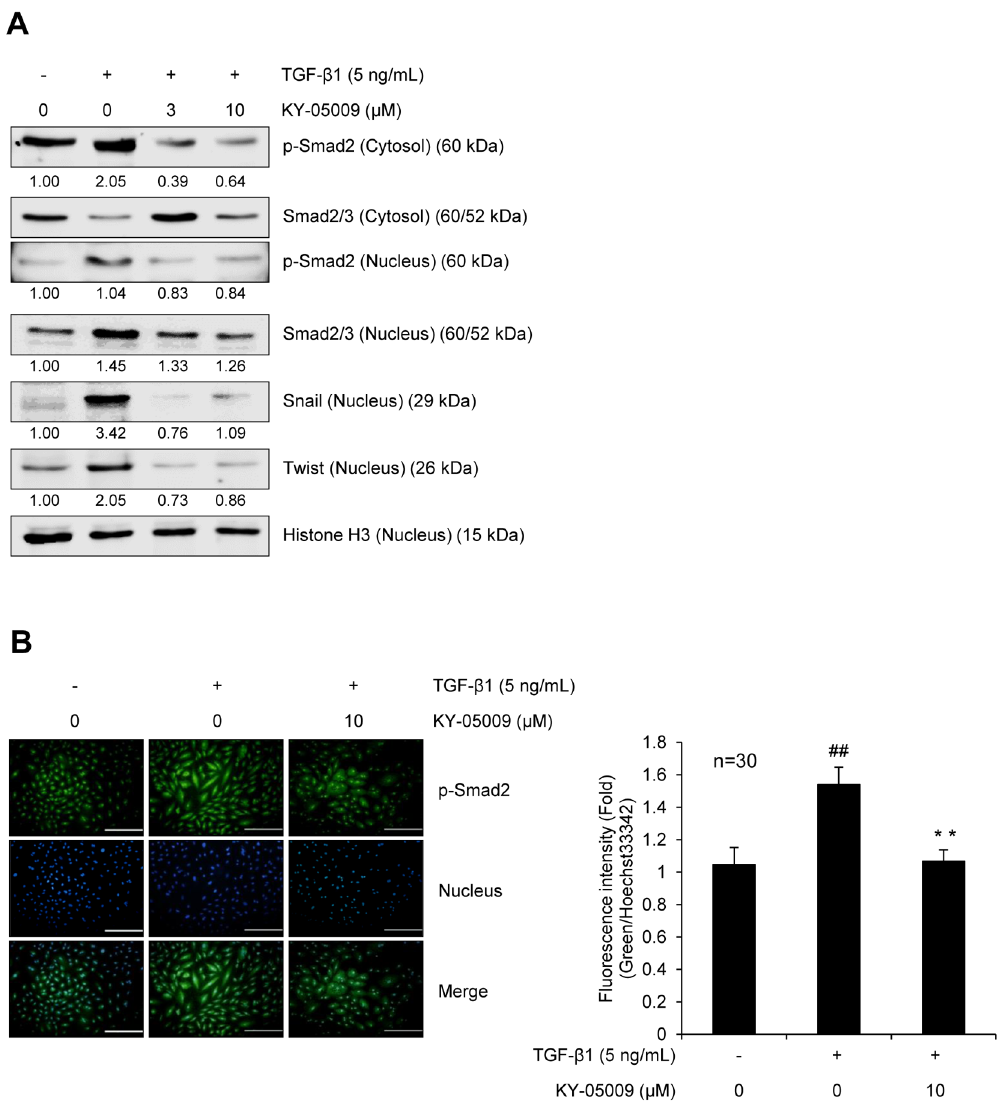
Figure 3. KY-05009 inhibits TGF- b 1-induced Smad signaling. (A) Effects of KY-05009 on TGF- b 1-activated Smad signaling. Serum-deprived A549 cells were treated with TGF- b 1 or its combination with KY-05009 for 48 h, and then the levels of p-Smad2 and endogenous Smad2/3 in cytosolic and nuclear fractions were evaluated by Western blot analysis. The nuclear expression levels of Snail and Twist were also evaluated. The expression of cytosol p-Smad2 was normalized by endogenous Smad2/3 and all nucleus proteins were normalized by histone H3. (B) Immunocytochemical confirmation of KY-05009 inhibition of TGF- b 1-activated p-Smad2. Nuclei were counterstained with Hoechst 33342. All scale bars represent 50 m m. The expression of p-Smad2 was represented by the relative intensity of green fluorescence (n=30), and reported images are representatives of triplicate experiments. ## p , 0.01 (versus ‘the control’), ** p , 0.01 (versus ‘the group treated with TGF- b 1 only’).